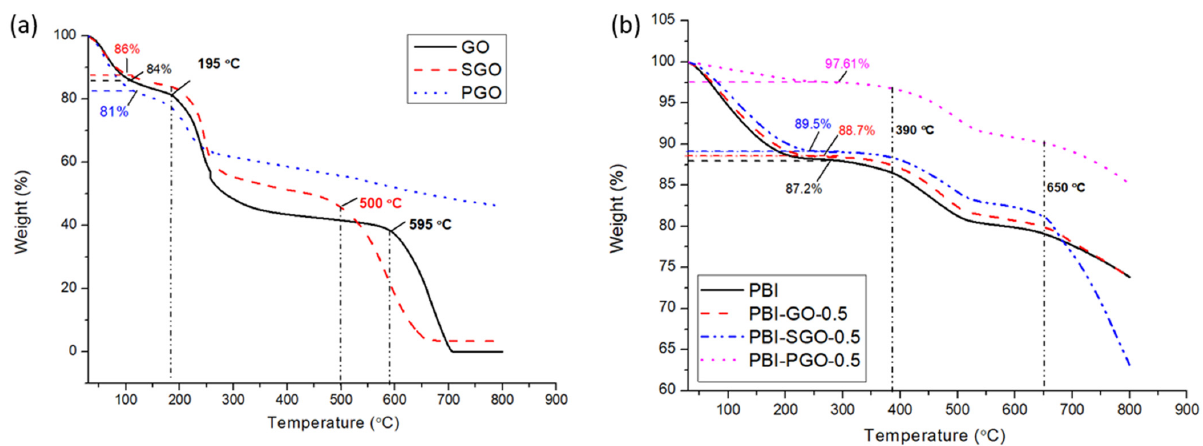
Figure 6. Thermogram of ( a ) fillers, and ( b ) composite membranes.